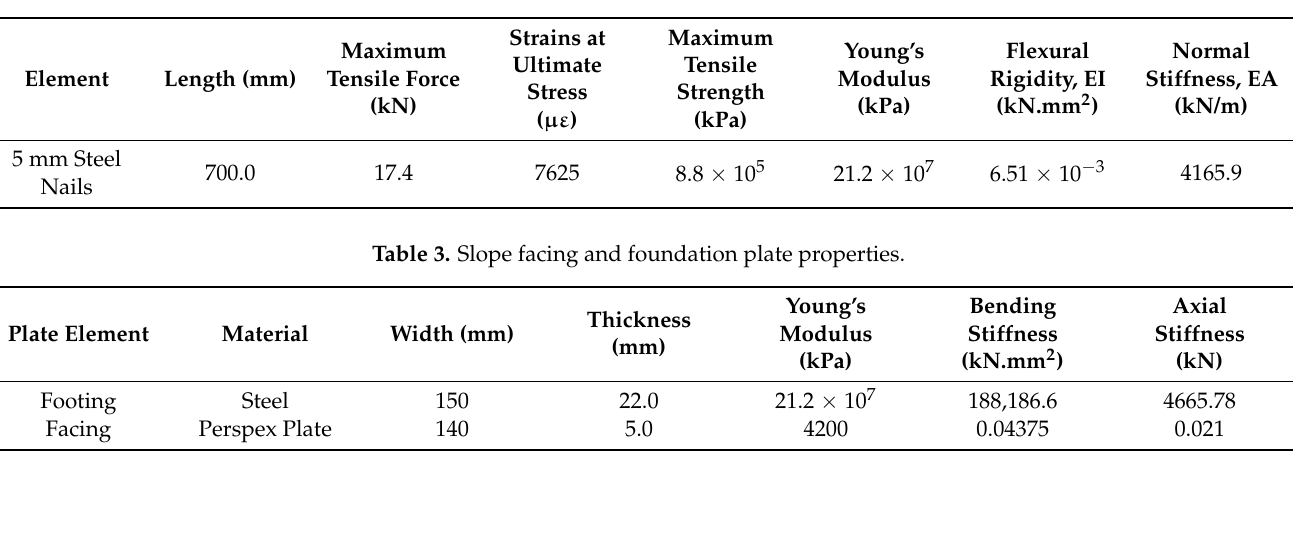
Figure 1. Testing loading frame, sand tank and slope facing panels; ( a ) loading frame; ( b ) sand tank; ( c ) slope facing panels. Table 2. Nail properties.